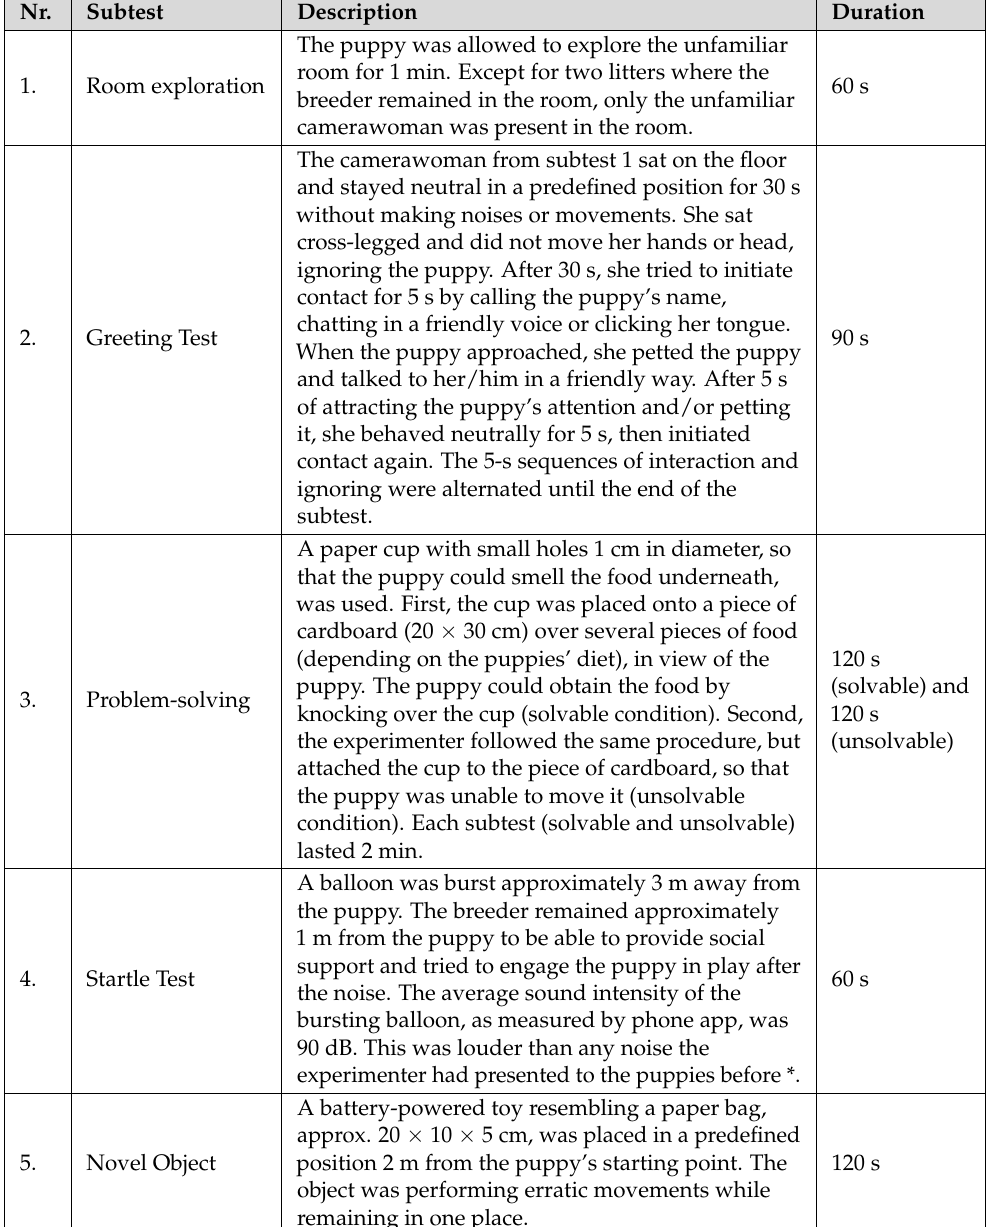
Table 3. Behaviour test at six to seven weeks of age (40–51